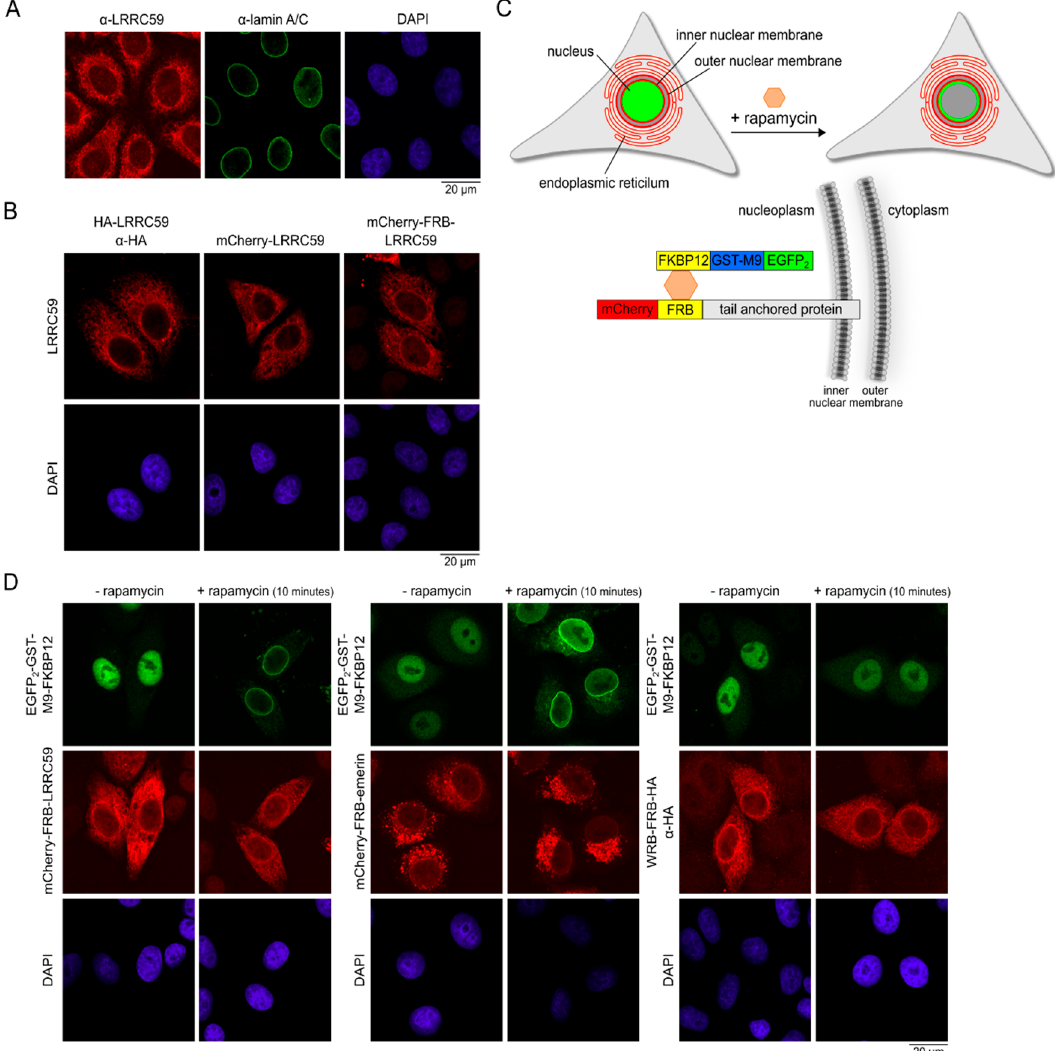
Figure 4. LRRC59 is targeted to the INM. ( A ) HeLa cells were grown on coverslips and analyzed by indirect immunofluorescence using antibodies against LRRC59 and lamin A/C. ( B ) HeLa cells were transfected with plasmids coding for HA-LRRC59, mCherry-LRRC59 or mCherry-FRB-LRRC59. Cells were fixed and analyzed directly (mCherry-LRRC59 and mCherry-FRB-LRRC59) or after immunostaining using an anti-HA antibody. ( C ) Schematic overview for the rapamycin-induced dimerization assay. Cells are transiently transfected with plasmids coding for the nuclear reporter EGFP 2 -GST-M9-FKBP12 (green) and the protein of interest tagged with mCherry and FRB (red). The addition of rapamycin (orange hexagon) leads to the dimerization of the FRB- and FKBP12-cassettes and to a recruitment of the reporter to the INM. ( D ) HeLa cells were co-transfected with plasmids coding for EGFP 2 -GST-M9-FKBP12 and mCherry-FRB-LRRC59, mCherry-FRB-emerin or WRB-FRB-HA, respectively, and treated with (+) or without ( − ) rapamycin for 10 min. Cells were fixed and analyzed directly (mCherry-FRB-LRRC59, mCherry-FRB-emerin) or after immunostaining using an anti-HA antibody (WRB-FRB-HA).